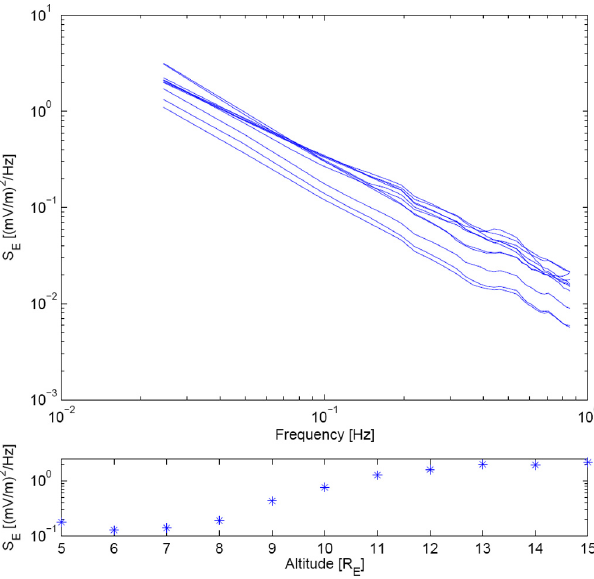
Fig. 2. Upper panel: The power spectral density for the electric field versus frequency observed at different geocentric distances (5– 15 R E ). The slope of the curves is approximately − 1.5. Lower panel: The average spectral density at each